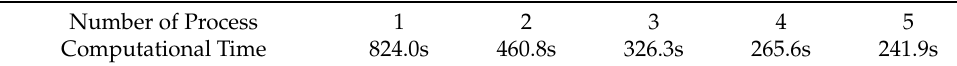
Table 6. Time consumption of multi-process parallel